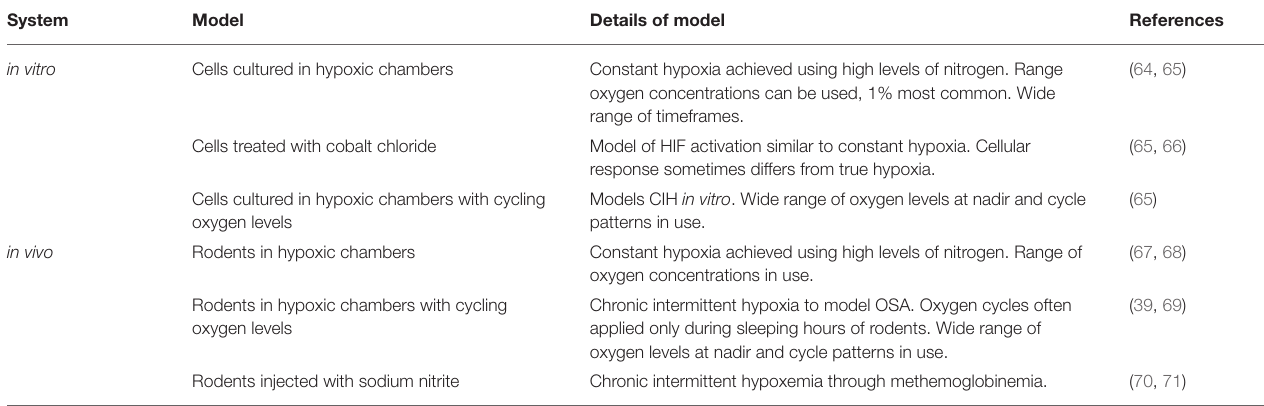
TABLE 2 | Relevant in vitro and in vivo models of chronic and chronic intermittent